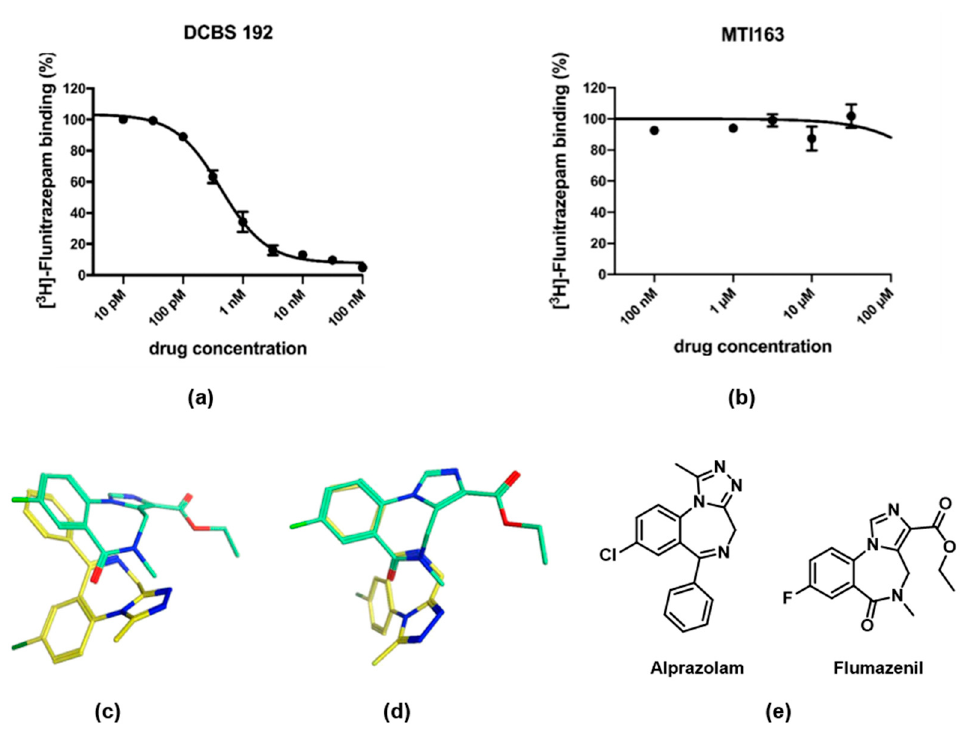
Figure 3. Radioligand displacement assay of [ 3 H]-Flunitrazepam by DCBS192 ( a ) and MTI163 ( b ). Membranes from rat cerebellum were incubated with 2 nM [ 3 H]-flunitrazepam in the presence of various concentrations of the two ligands. Data shown are the mean ± SEM of three independent experiments performed in duplicates each. ( c , d ) Superposition of the flumazenil bound 6D6T (green) and the alprazolam bound 6HUO (yellow) in two di ff erent perspectives demonstrate that the structurally related molecules do not bind with aligned pharmacophore features at all. The heteroatoms of the molecules are depicted in di ff erent colors: blue-nitrogen, red-oxygen, green-chloro. ( e ) Structures of alprazolam and flumazenil.